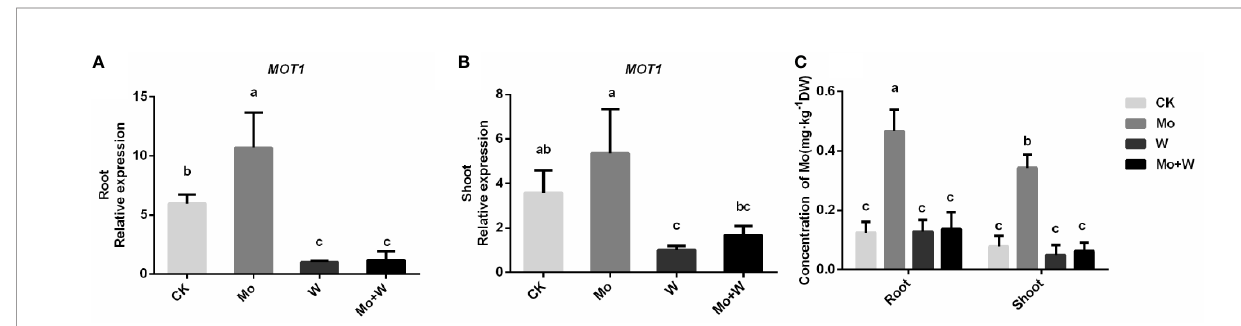
FIGURE 9 | MOT1 gene expressions in the roots (A) , shoots (B) , and molybdenum concentration of roots and shoots (C) of strawberry seedlings applied with treatments (CK, Mo, W, Mo+W). Data is presented as the means ± SD, n = 3. Different letters above bars denote statistical signi fi cance according to one-way ANOVA and Duncan ’ s test (P <